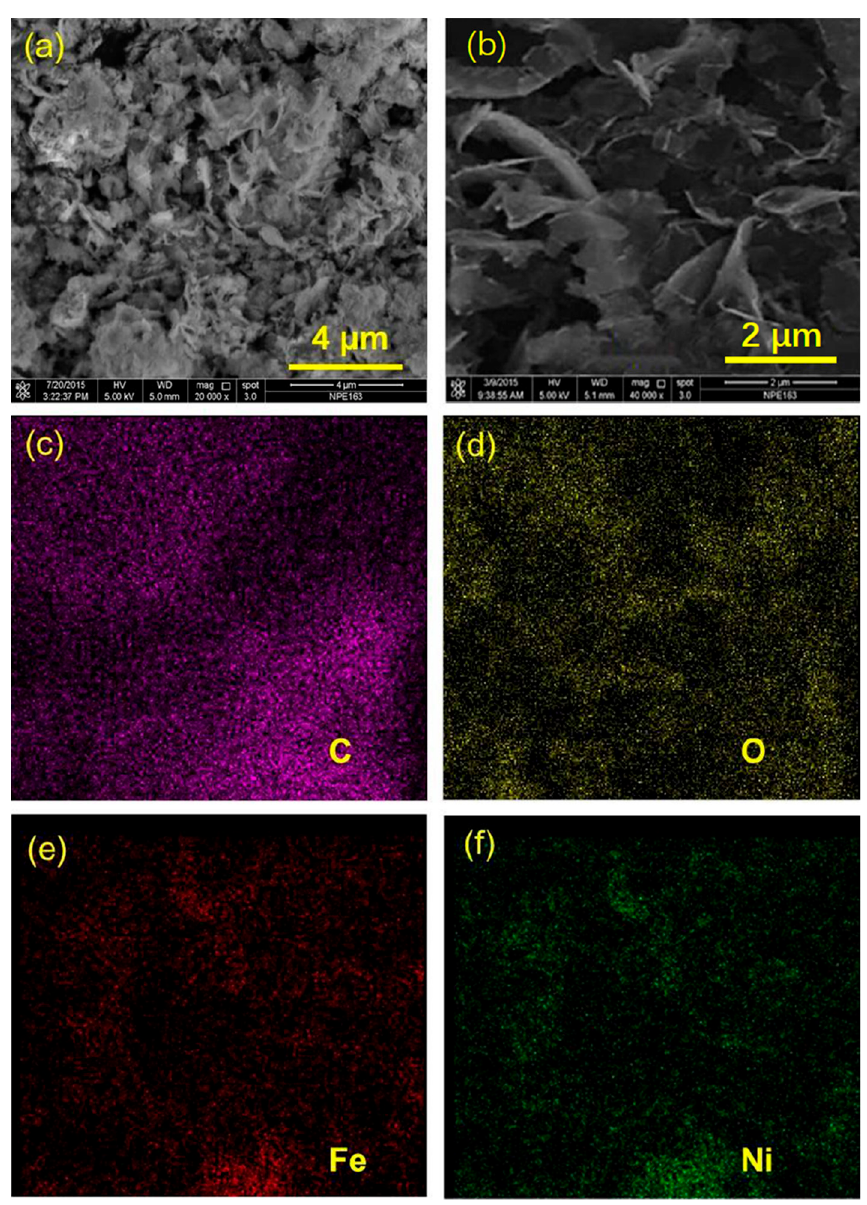
Figure 2. ( a,b ) Sanning electron microscopy (SEM) images and ( c,d,e,f ) elemental mapping of NiO- ( a,b ) Sanning electron microscopy (SEM) images and ( c–f ) elemental mapping of NiFe 2 O 4 -rGO. NiO-NiFe 2 O 4